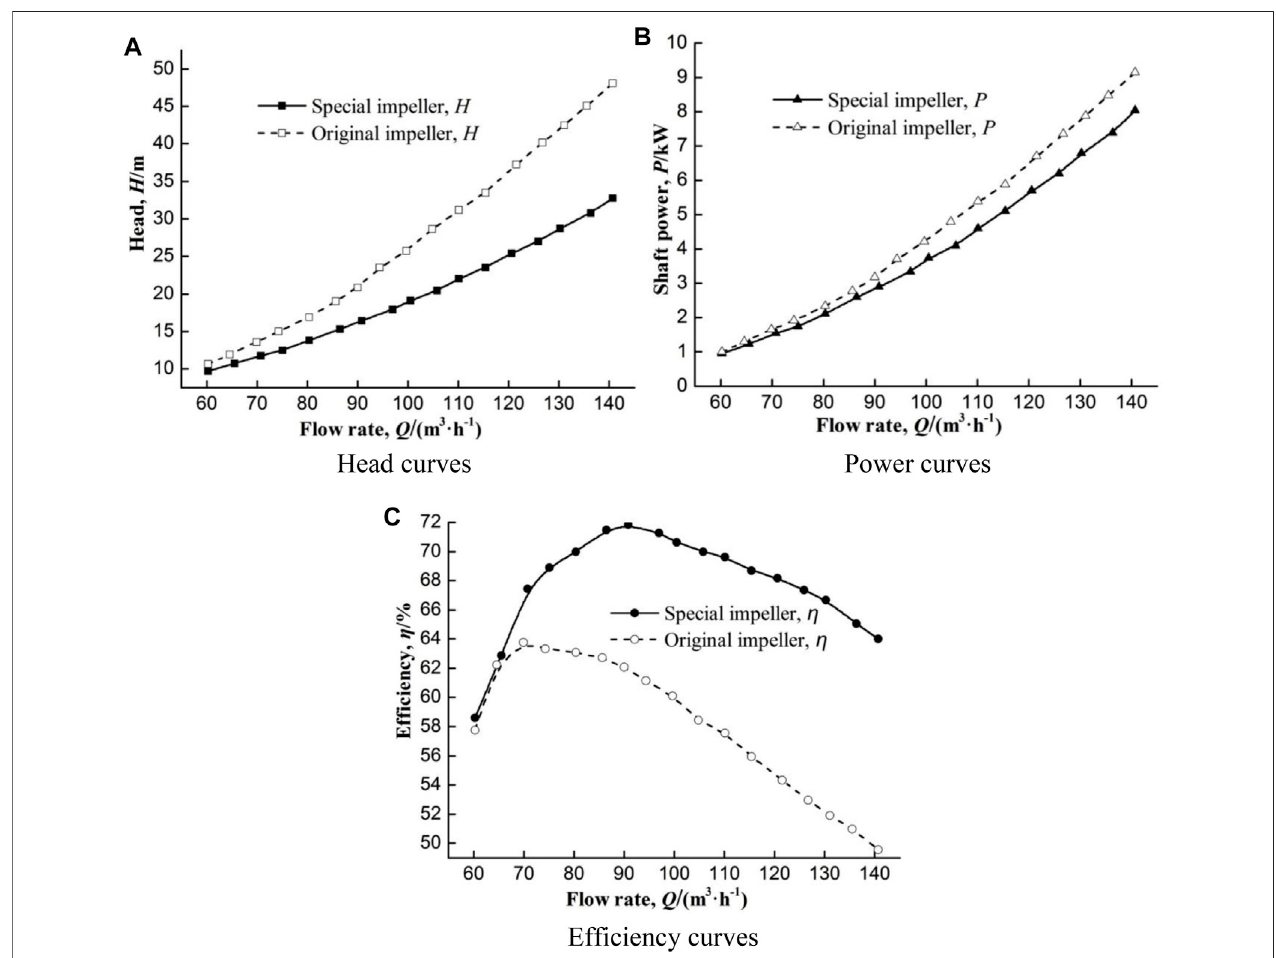
FIGURE 7 | Performance curves of PAT with original and special impellers (Wang et al., 2017a). (A) Head, (B) Power, (C) Ef fi ciency.